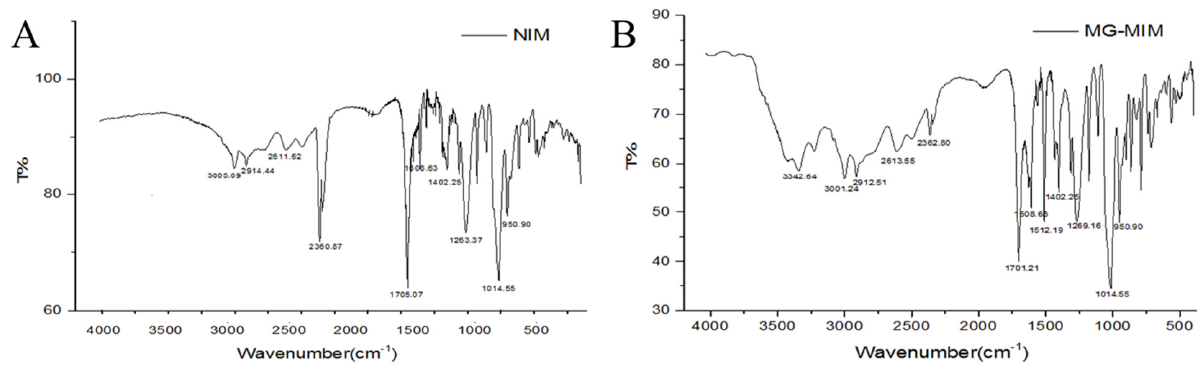
Figure 4. FT-IR spectra of NIM ( A ) and MG-MIM ( B Figure 4. FT ‐ IR spectra of NIM ( A ) and MG-MIM ( B ). Figure 4. FT ‐ IR spectra of NIM ( A ) and MG-MIM ( B ).